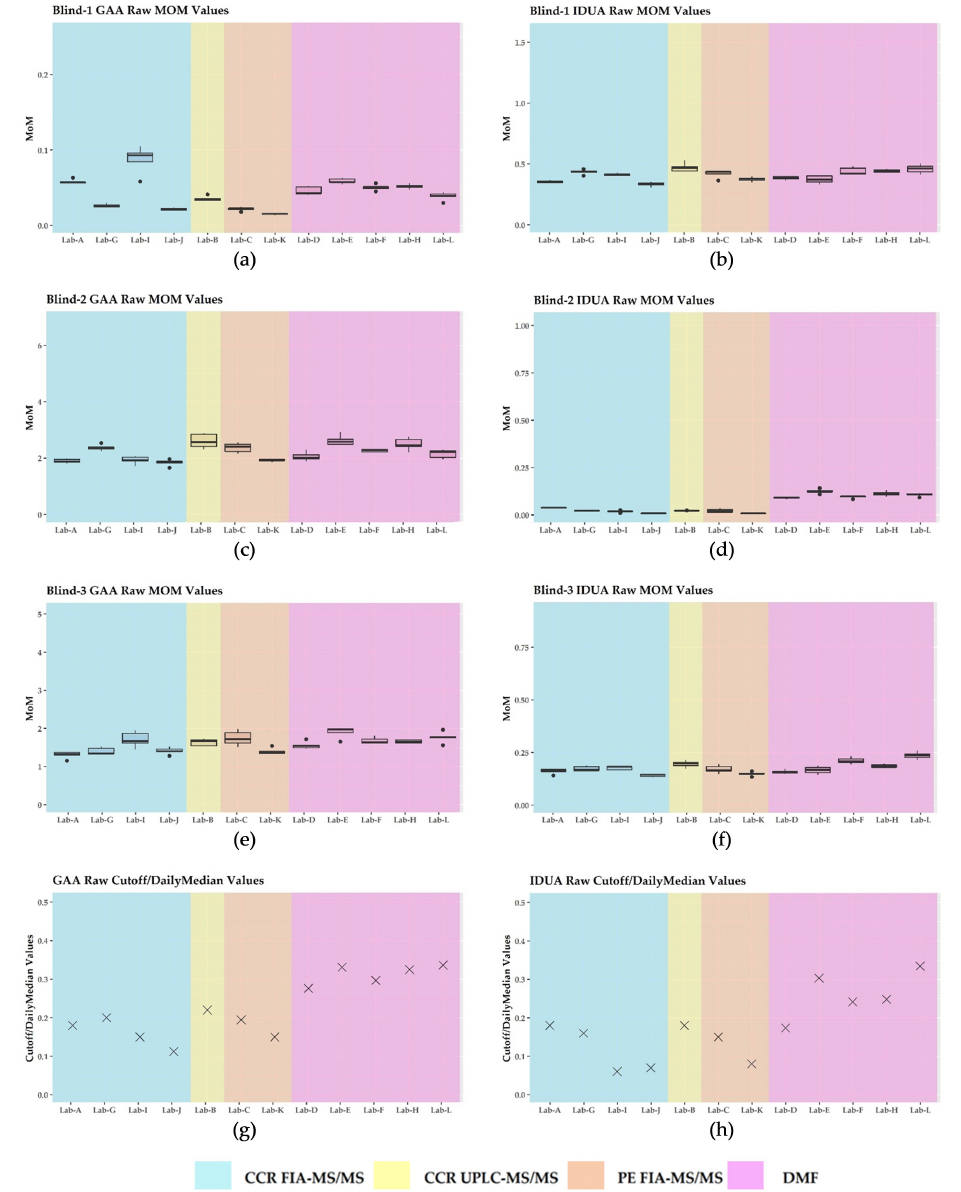
Figure 4. Plots for daily MoM by laboratory: ( a ) deficient GAA enzyme activity specimen; ( b ) normal IDUA enzyme activity specimen; ( c ) normal GAA enzyme activity specimen; ( d ) deficient IDUA enzyme activity specimen; ( e ) normal GAA enzyme activity specimen; ( f ) low IDUA enzyme activity specimen; ( g ) GAA MoM cutoff; ( h ) IDUA MoM